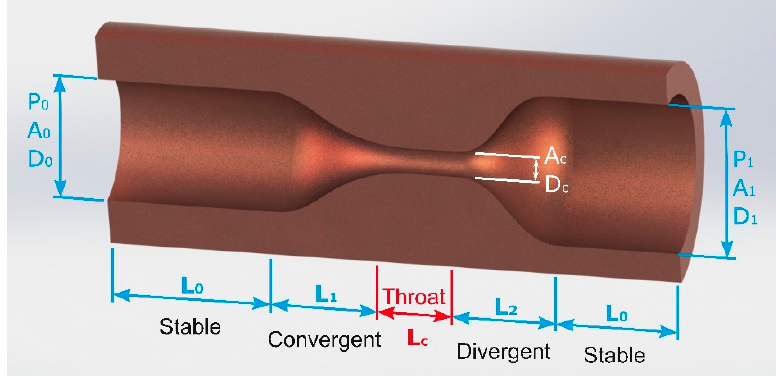
Figure 15. Scheme of a converging-diverging nozzle showing the different sections which compose the nozzle. Reprinted with permission from [69]; Copyright 1997 Elsevier.